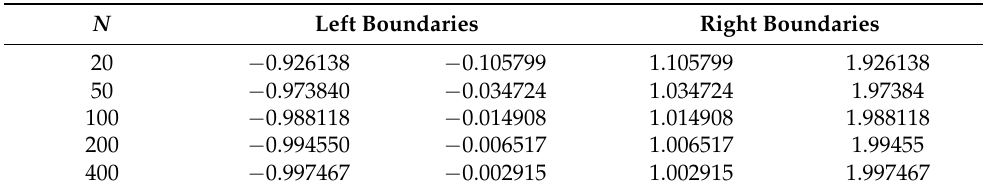
Figure A7. The zeros of P N ( E ) in units of λ 2 for N = 100. Table A2. The boundaries of the left and right energy bands in units of λ 2 for different values of N . The exact values are − λ 2 , 0, λ 2 , and 2 λ 2 .